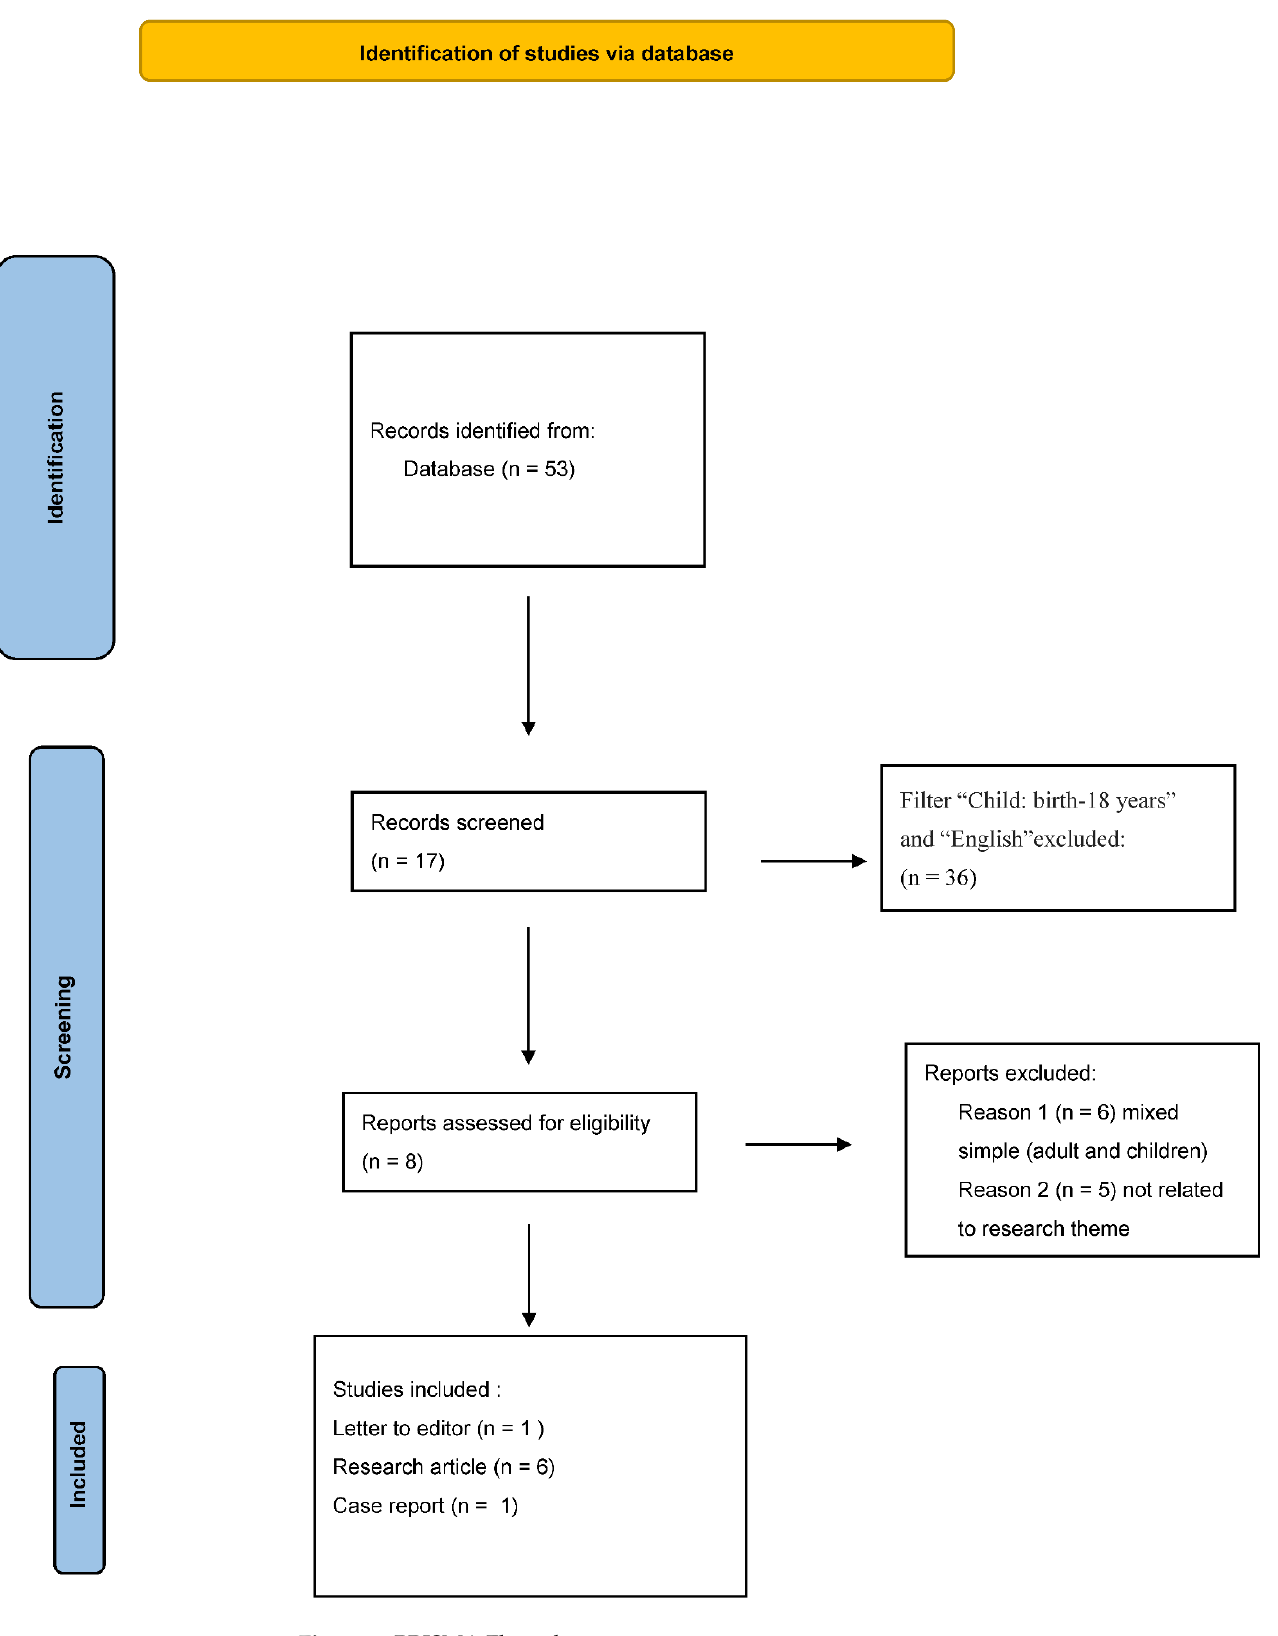
Figure 1. PRISMA Flow-chart.